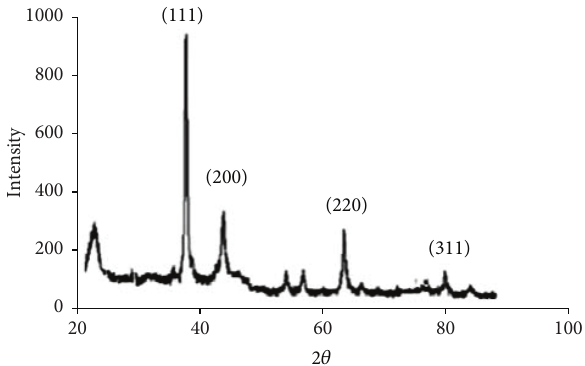
Figure 6: X-ray diffraction pattern of the synthesis of silver nanoparticles using peroxidase enzyme from Euphorbia ( Euphorbia amygdaloides ).